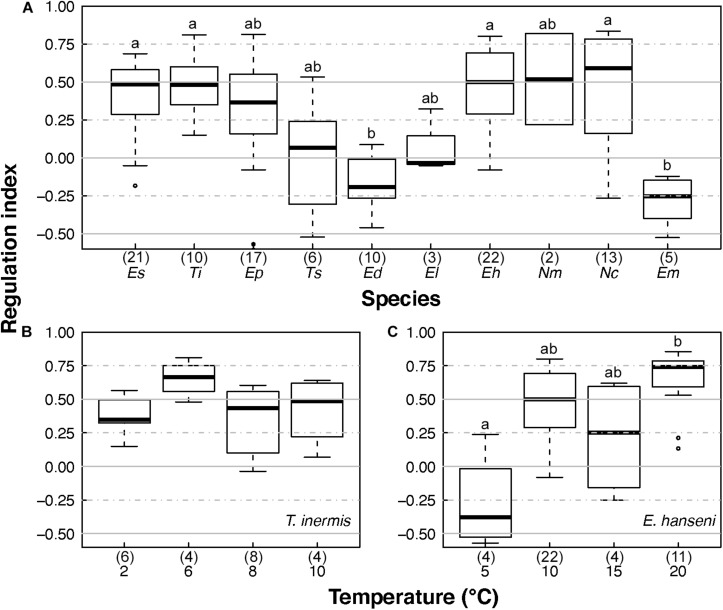
Euphausiids’ regulation indices at in situ temperature and after temperature acclimation. (A) Regulation indices of the 10 euphausiid species investigated at in situ temperature, (B) regulation indices of T. inermis acclimated at 2, 6, 8, and 10°C, and (C) regulation indices of E. hanseni acclimated at 5, 10, 15, and 20°C. Es, E. superba; Ti, T. inermis; Ep, E. pacifica; Ts, T. spinifera; Ed, E. distinguenda; El, E. lamelligera; Eh, E. hanseni; Nm, N. megalops; Nc, N. capensis; Em, E. mucronata. Numbers in parentheses give the numbers of samples analyzed. Horizontal bars in the box plots indicate the median. The upper and lower edges of the rectangles show the first and third quartiles, respectively. Vertical error bars extend to the lowest and highest values in a 1.5-fold inter-quartile range (R Core Team, 2020). Lower case letters indicate significant differences.